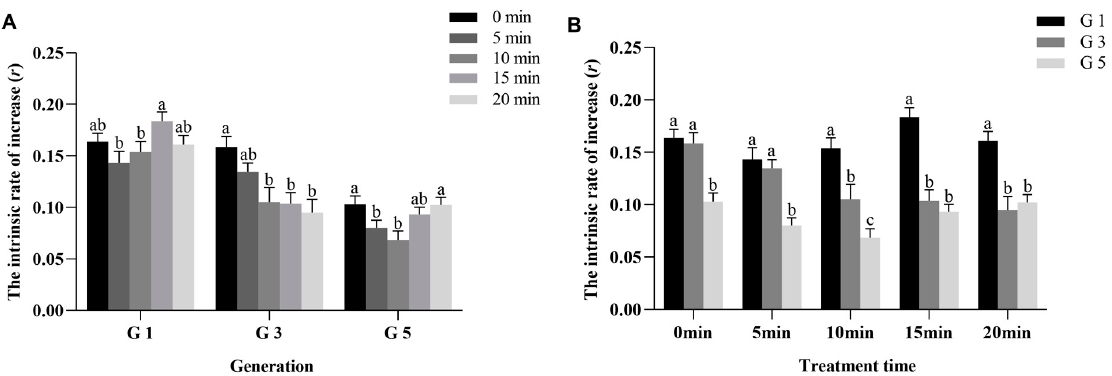
Figure 3. Intrinsic natural increase rate ( r ) of the first, third, and fifth generations of P. xylostella under HVEF stress. Note: Values are expressed as mean ± standard error (SE). ( A ) The different lowercase letters indicates a significant difference at p < 0.05 between generations for groups exposed to electrostatic fields (0, 5, 10, 15, and 20 min). ( B ) The different lowercase letters indicates significant differences at p < 0.05 between treatments for 3 generations (G1, G3, and G5). Differences were compared using the paired bootstrap test.